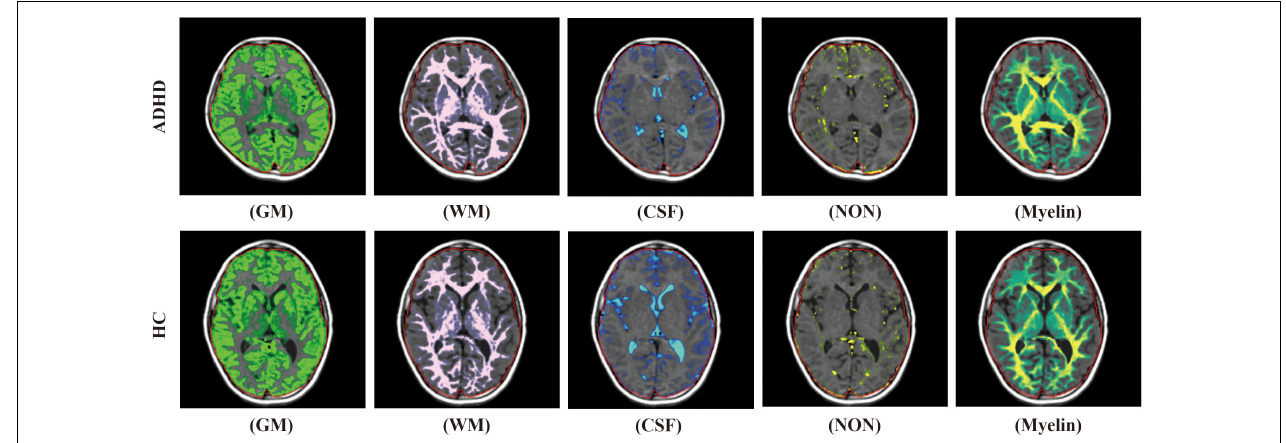
FIGURE 1 | The diagrammatic images of automatic brain segmentation acquired in an ADHD child (upper row) and a child from the control group (lower row) (WM, white matter; GM, gray matter; CSF, cerebrospinal fluid; NON, non-GM/WM/CSF).